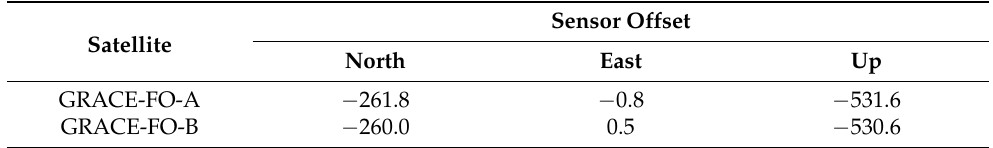
Table 3. Sensor Offset of GRACE-FO satellites (unit: